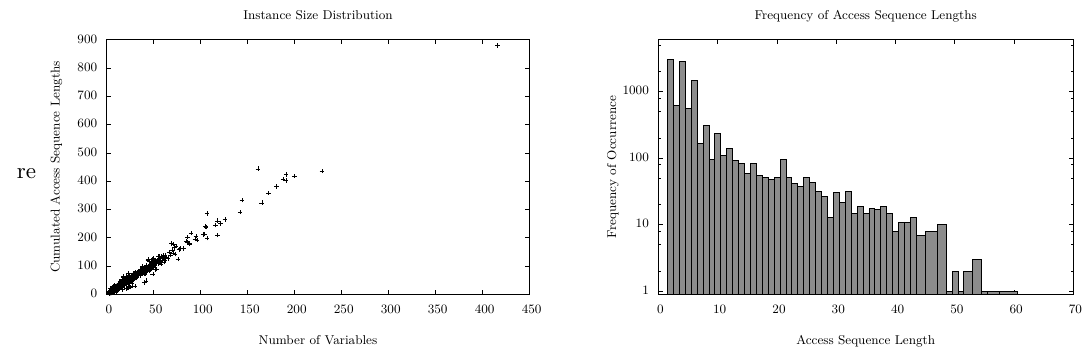
Figure 8 Distribution of the number of variables and access lengths across the 1 , 918 instances.